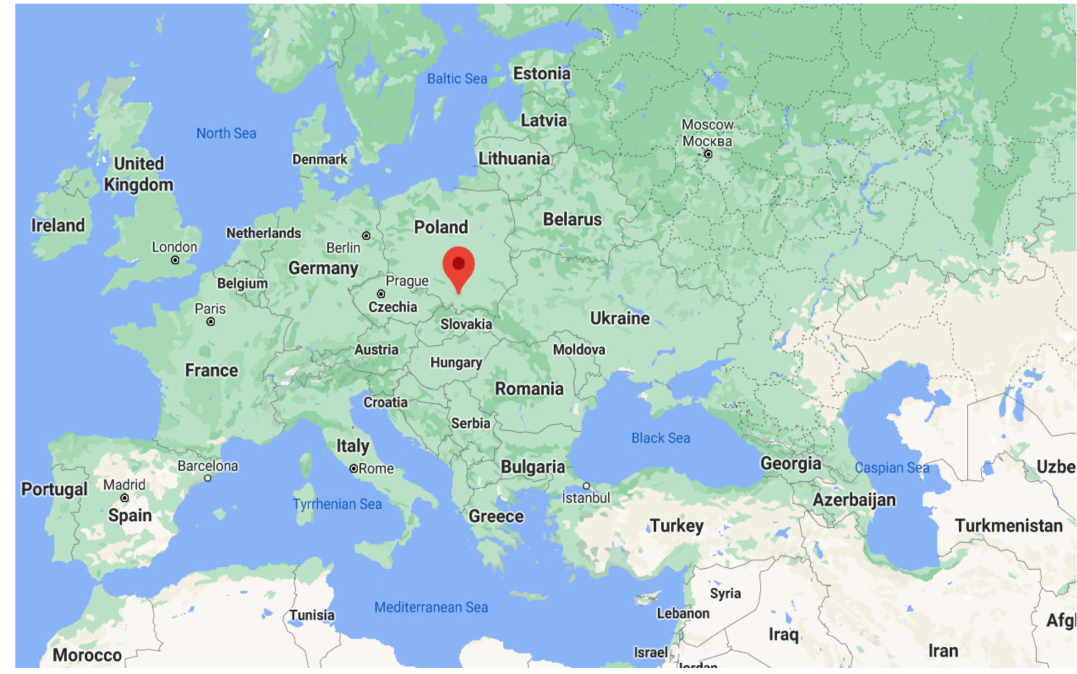
Figure 1. Location of the study site. Source: https://www.google.com/maps/ (Accessed on 17 January